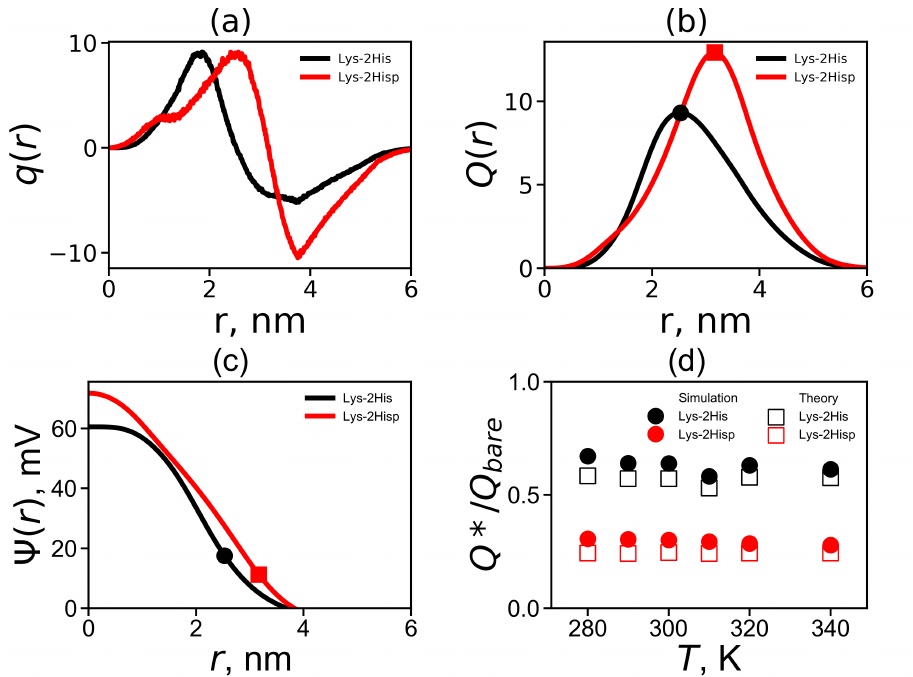
Figure 6. ( a ) The total charge distribution q ( r ) , ( b ) the cumulative charge distribution Q ( r ) , ( c ) the electrostatic potential Ψ ( r ) for Lys-2His and Lys-2Hisp at T = 310 K and ( d ) the temperature dependencies of the relative effective charge Q ∗ / Q bare